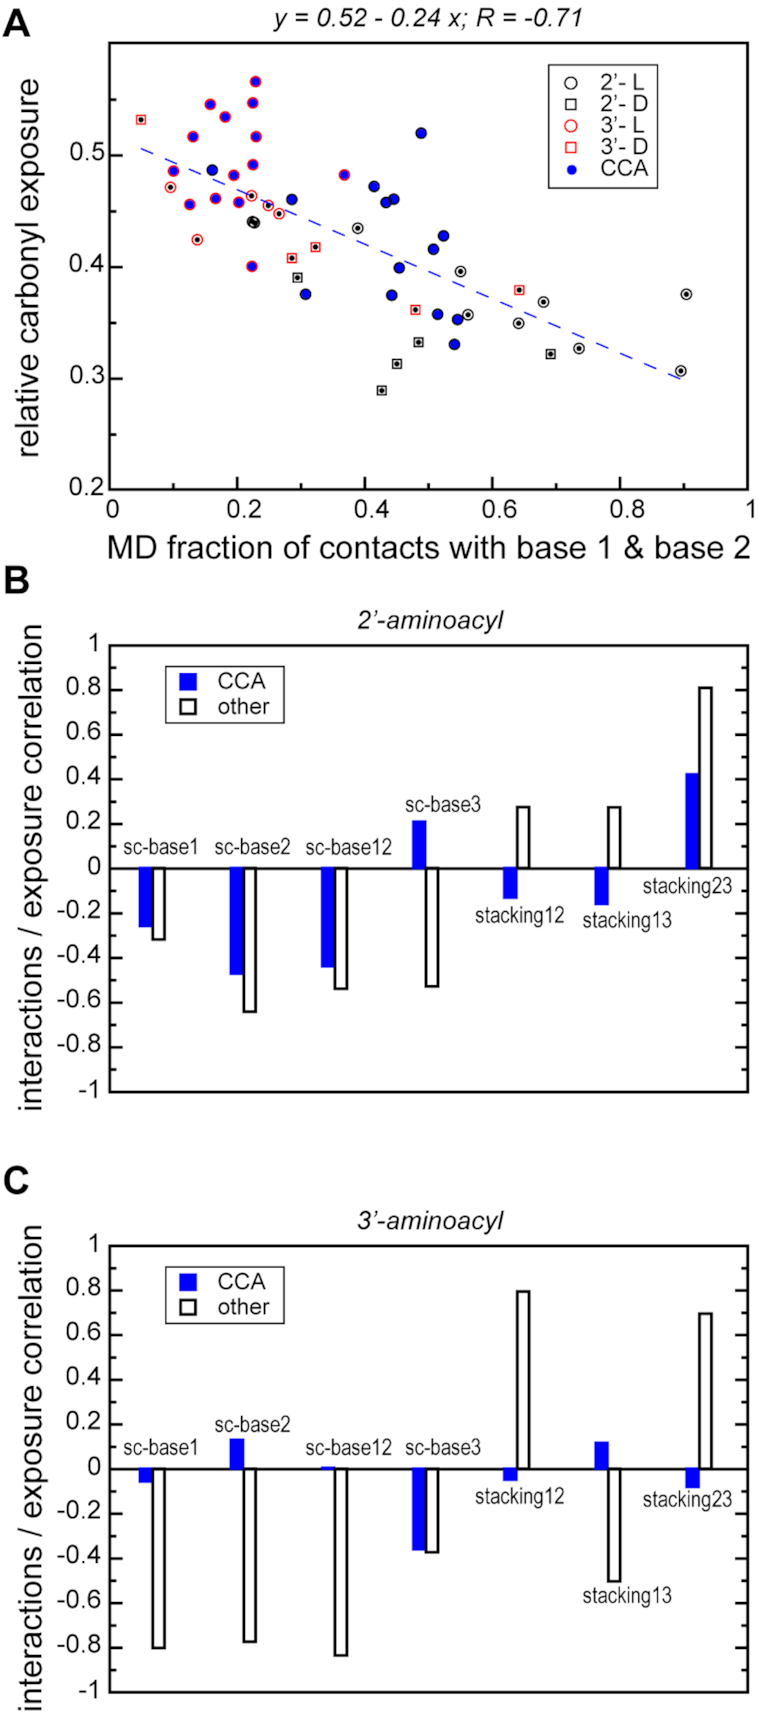
Interactions tune carbonyl solvent exposure. (A) An exemplary linear regression between the average relative carbonyl solvent exposure and sidechain interactions with the first and the second bases estimated as MD fractions of distances < 8 Å between sidechain and base centers-of-geometry (COGs). The results for L- and D-aminoacylated trinucleotides are depicted with circles and rectangles, respectively, while for 2′- and 3′-modified trinucleotides they are shown in black and red, respectively. (B, C) Pearson correlation coefficients between the sidechain interaction strengths with different bases or the stacking between bases and the average relative carbonyl solvent exposure in the case of 2′-modified (B) and 3′-modified trinucleotides. The open and blue bars correspond to non-CCA and CCA trinucleotides, respectively.